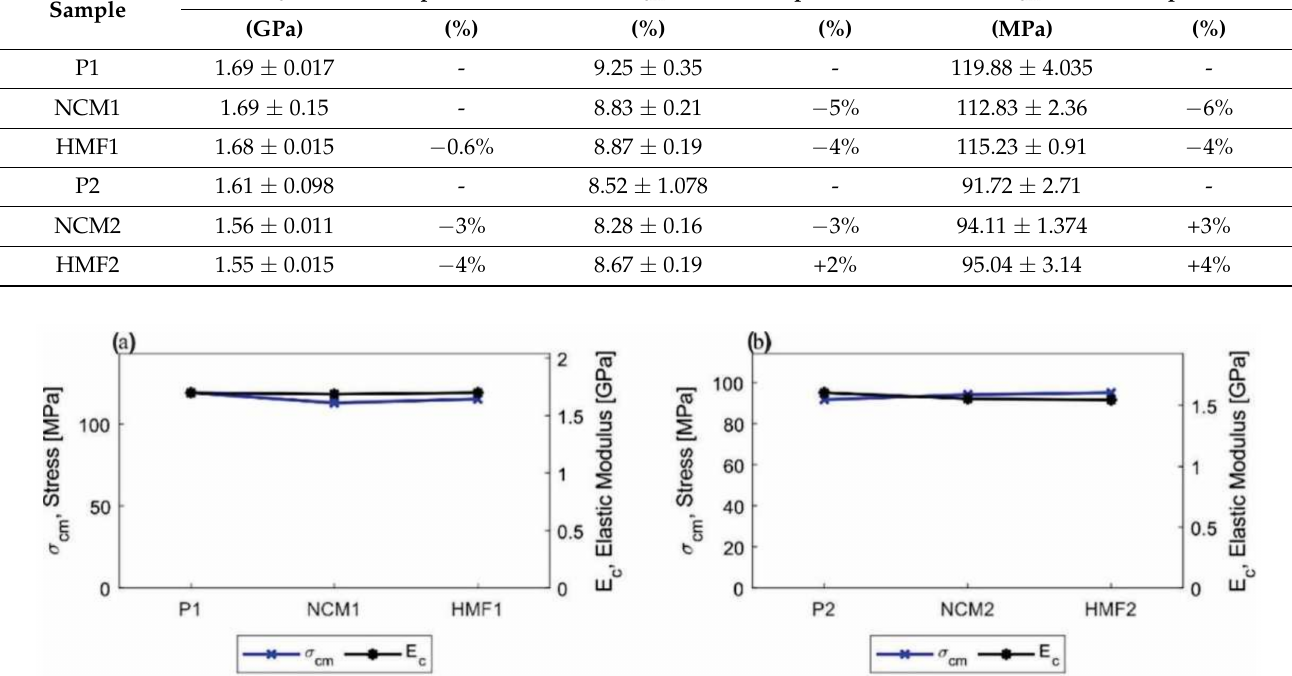
Figure 9. Graphic comparative summary of the maximum effort and elastic modulus in compres- sion. ( a ) Specimens manufactured with configuration 1 (P1, NCM1, and HFM1) and ( b ) specimens manufactured with configuration 2 (P2, NCM2, and